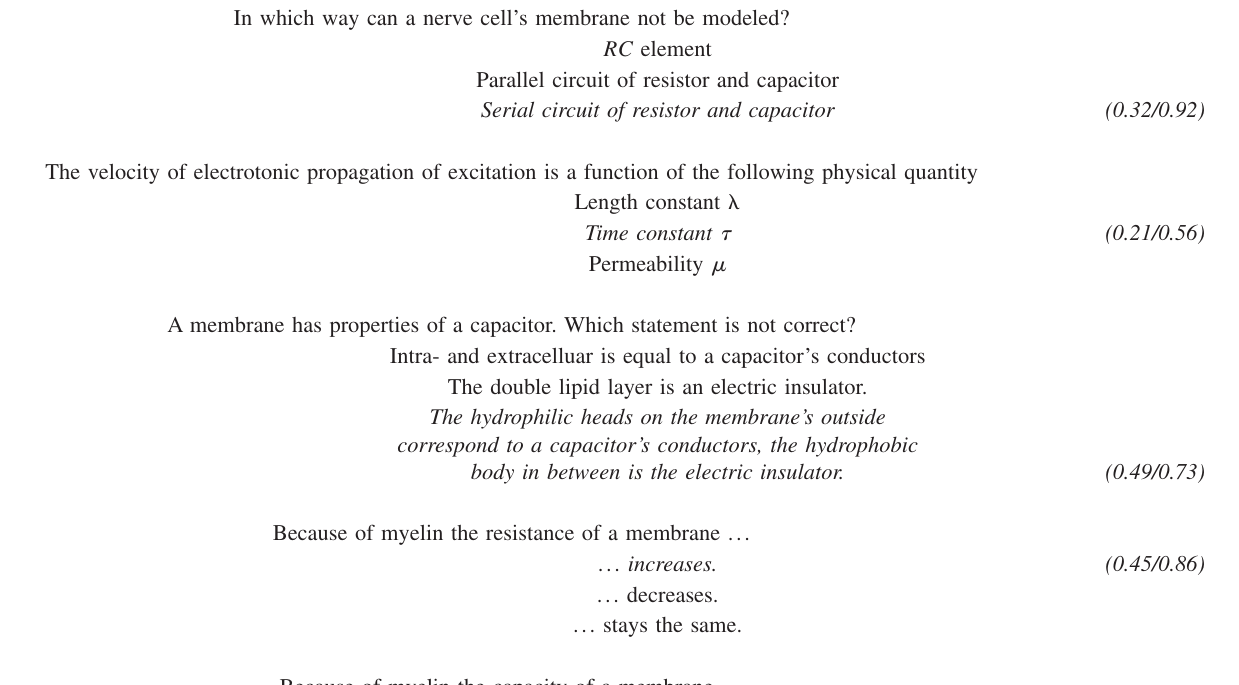
TABLE II. MC questions used in the assessment. The correct answer is printed in italics, the fraction of correct answers is given each for control group and treatment group in brackets. For all questions the answer “I don’t know” was given in addition. In which way can a nerve cell’s membrane not be